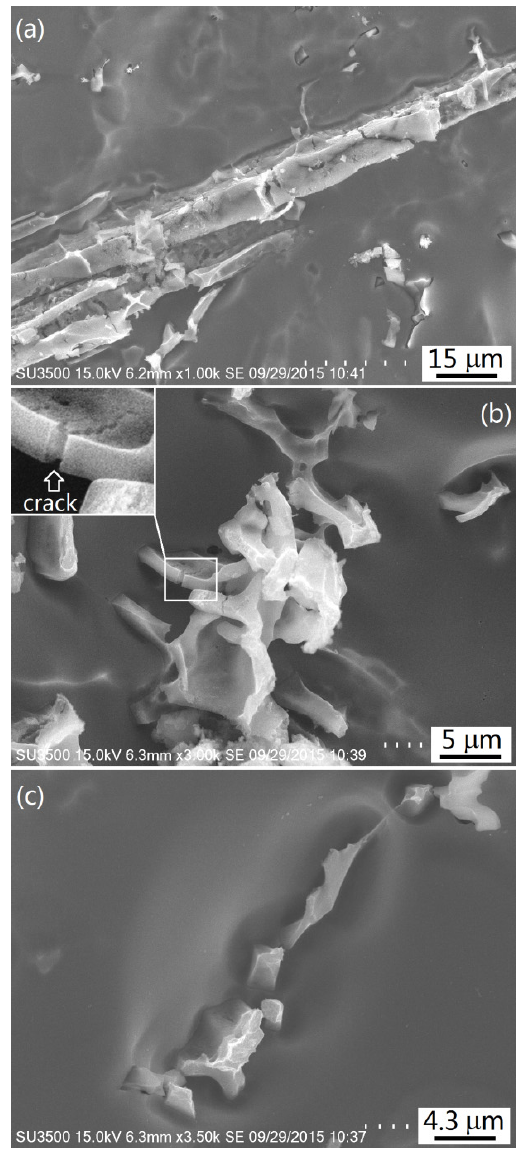
Figure 6. The deep etched images of the intermetallics: ( a ) Primary Al 6 (Fe,Mn); ( b ) eutectic Al 6 (Fe,Mn); ( c ) Mg 2 Si.